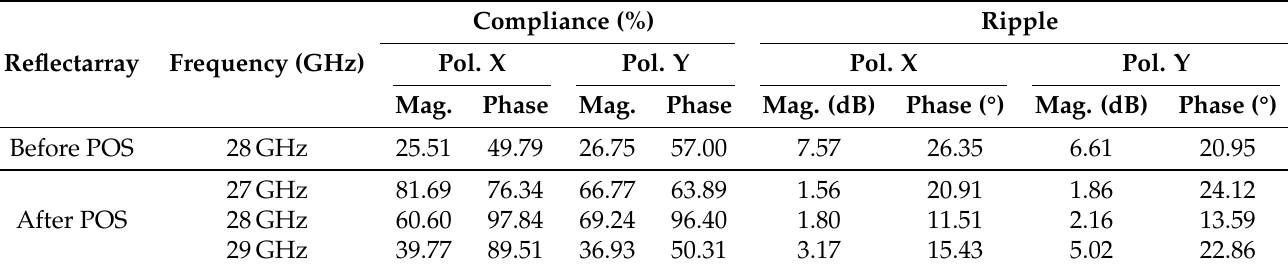
Table 1. Performance of the reflectarray before and after the POS with the GIA at a plane 0.5m away from the antenna. After the POS, the layout is simulated at three different frequencies within the 5G FR n257 band to assess the performance. Before POS, results are only shown at 28GHz since ideal phase-shifters are assumed. Compliance (%) indicates percentage of surface in Ω 1 that complies with